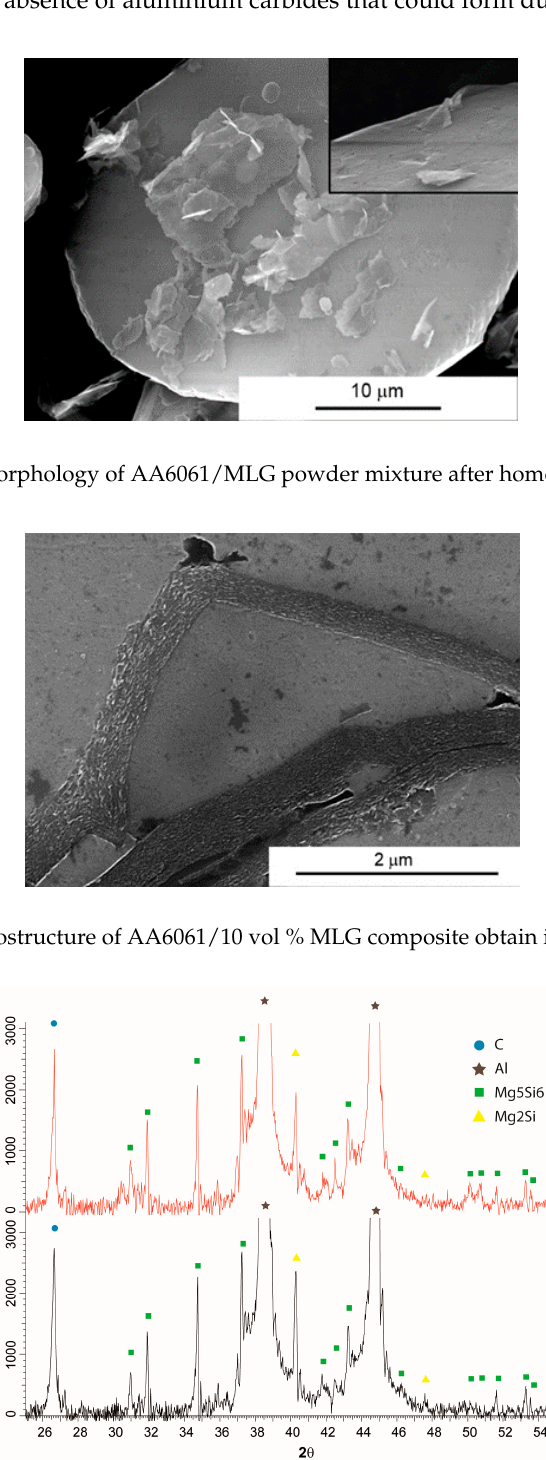
Figure 8. Diffraction pattern of SPS (red line) and SPT (black line) AA6061/10 vol % MLG composites.